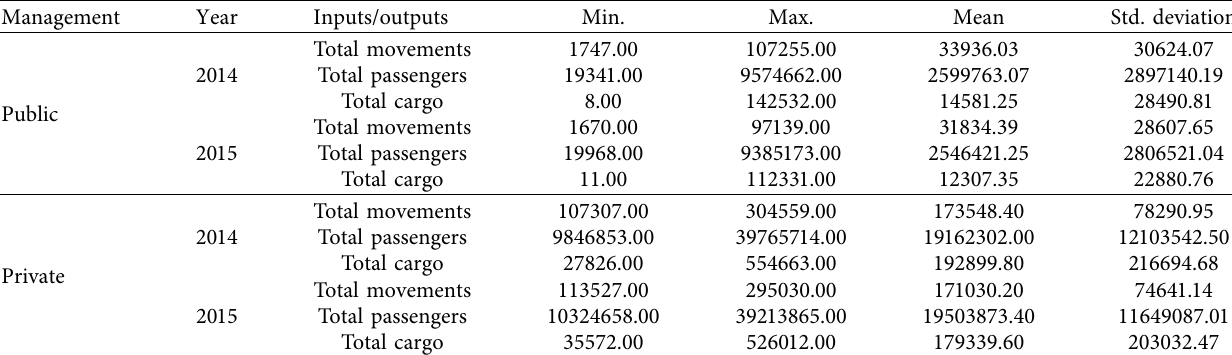
Table 2: Descriptive statistics of inputs and outputs by